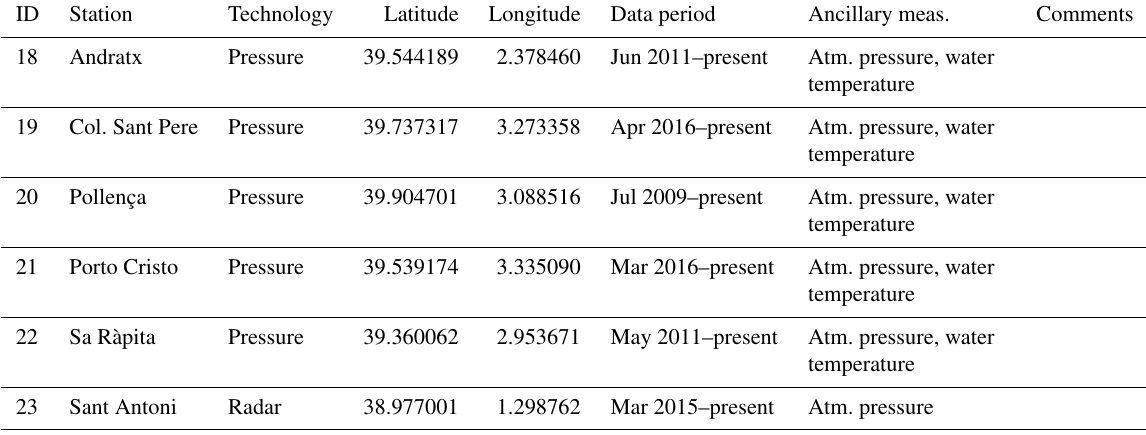
Table A2. Tide gauge stations in the Balearic Islands, Spain, operated by SOCIB.